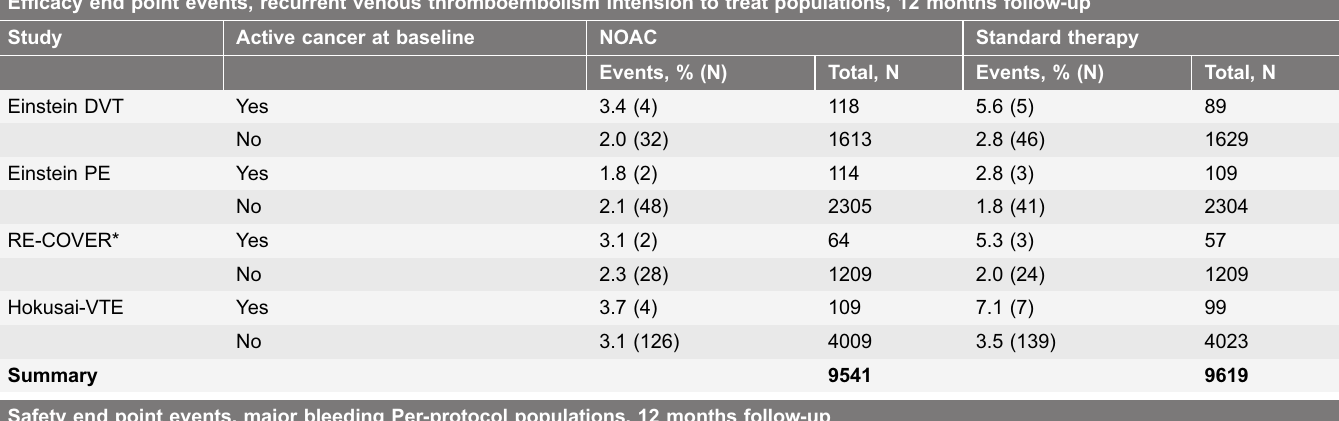
Table 2. Clinical outcomes in acute treatment of venous thromboembolism in patients with and without